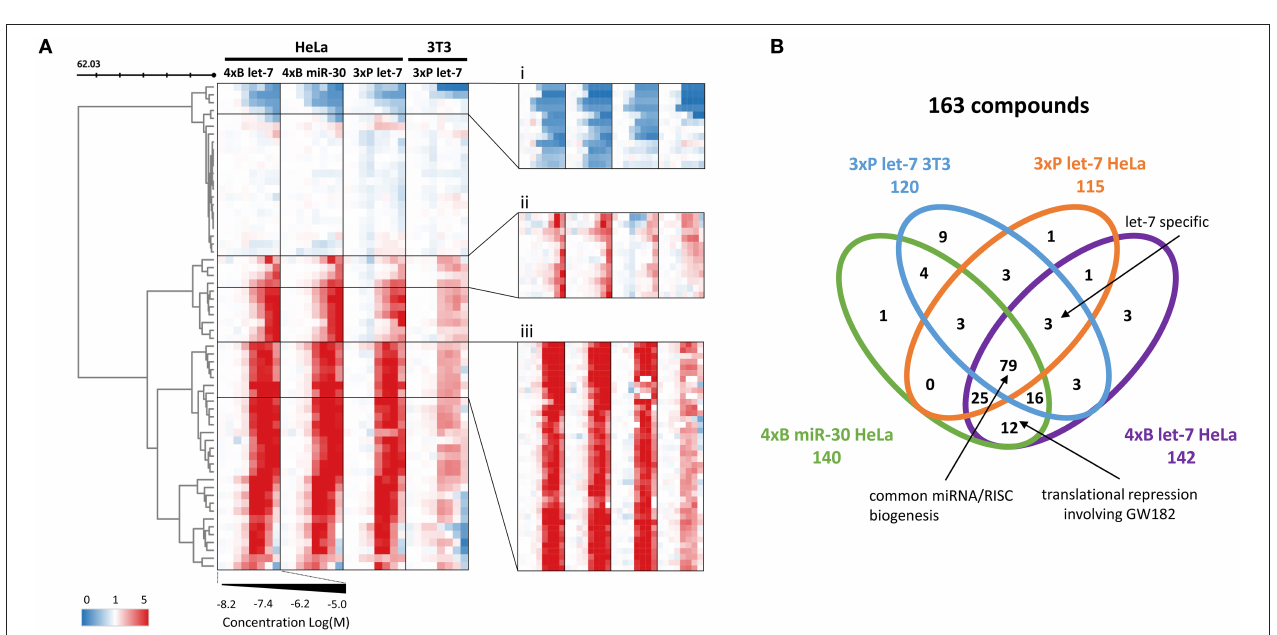
FIGURE 4 | Validation dose-response analysis. (A) Cluster analysis of 248 compounds (primary screening hits) based on their concentration-dependent effect on the reporters. The compounds’ profiles were compressed according to their Euclidean distance (50 rows) to reveal the main motifs contained in the data. Zoomed clusters (i-iii) depict individual compounds, showing three different concentration-dependent types of effects on the reporters: (i) putative miRNA pathway-stimulating compounds, (ii) less potent putative miRNA pathway inhibitors, (iii) the most abundant activity profile of the putative miRNA pathway inhibitors. (B) Venn diagram depicting distribution of the activities of putative miRNA pathway inhibitors in different reporter assays.